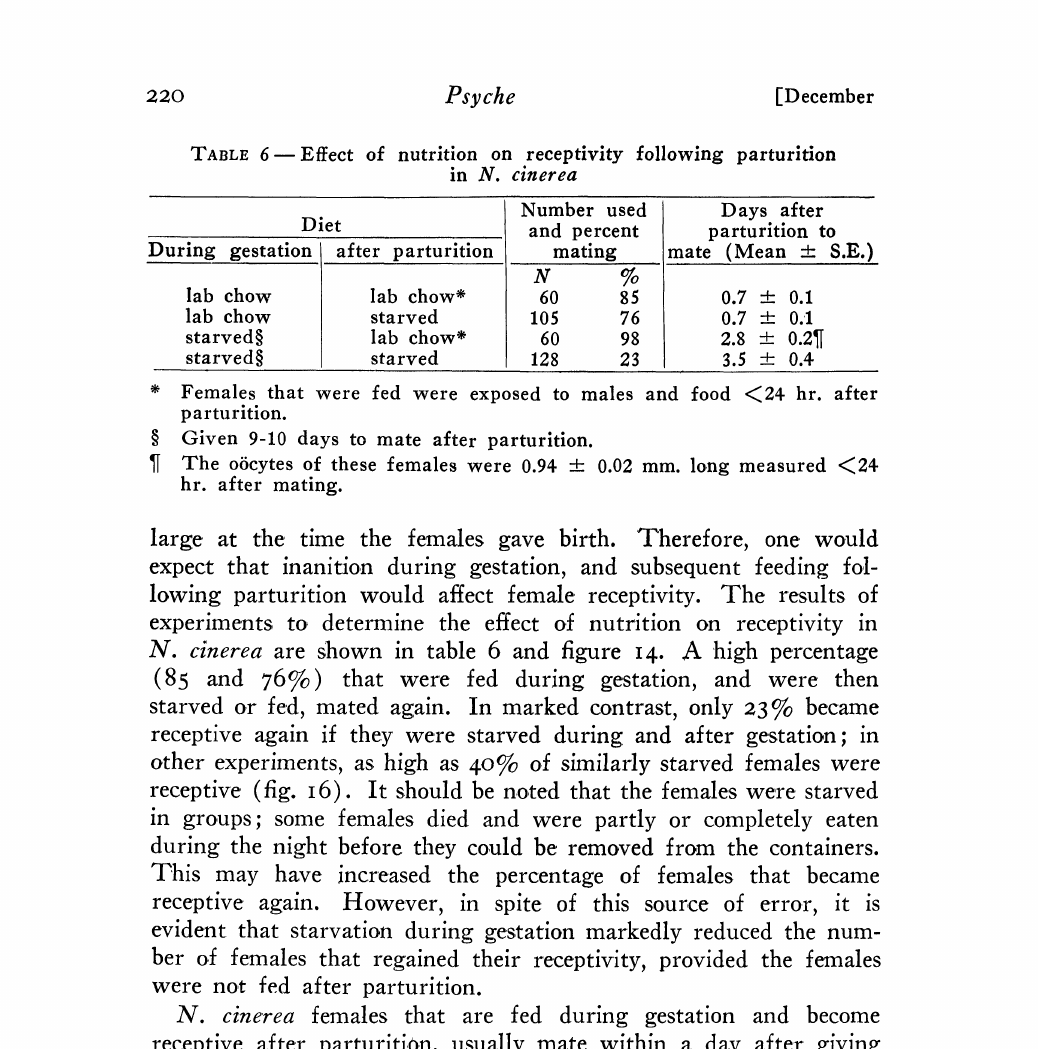
TABLE 6 mEffect Of nutrition on receptivity following parturition in N.